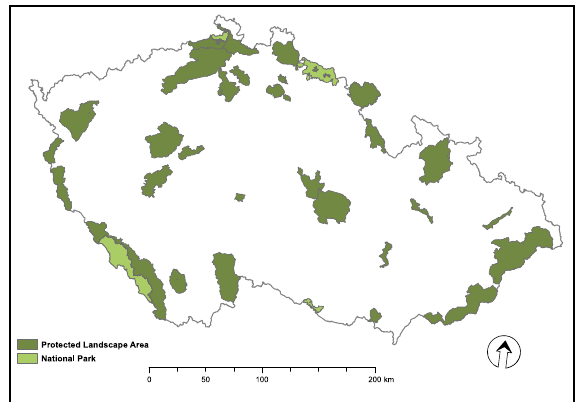
Fig. 8. National parks and protected landscape areas in Czechia. Source: Agency for nature Conservation and Landscape Protection of the Czech Republic 2012. Drawn by